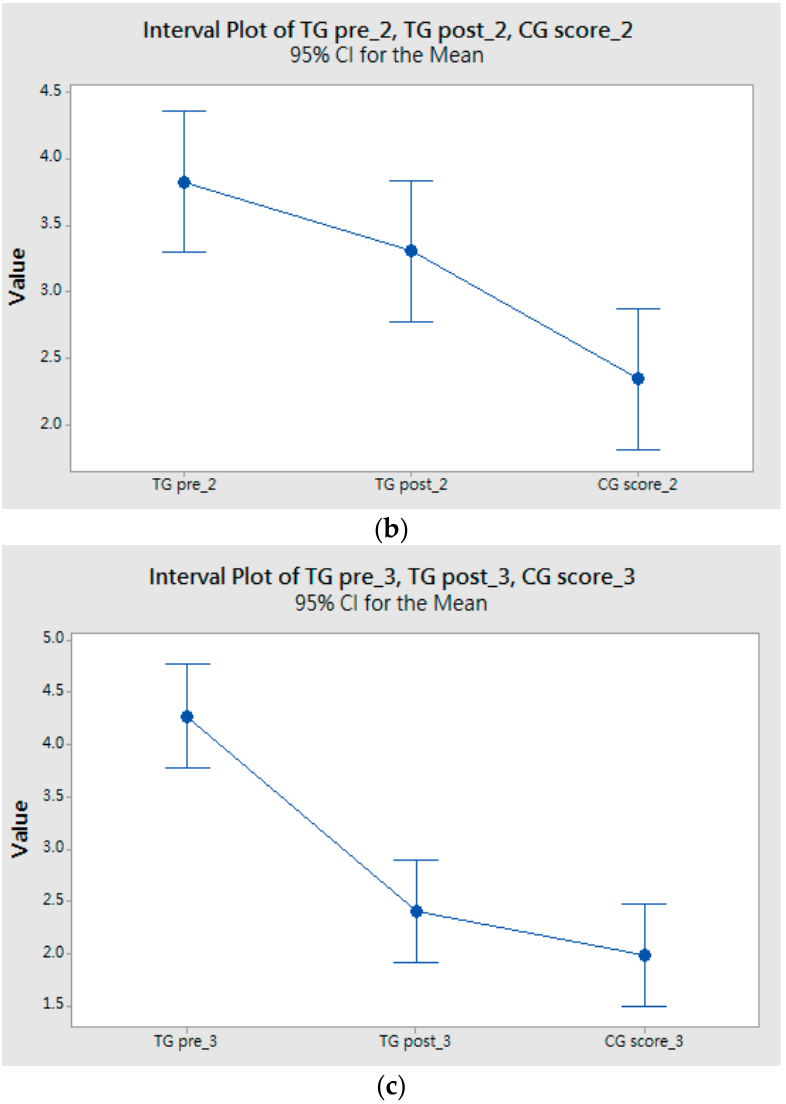
Figure 8. ( a ) One-way ANOVA interval plot from anxious driving behavior questionnaire (Q1~Q19); ( b ) one-way ANOVA interval plot from anxiety-related-avoidance questionnaire (Q20~Q32); and ( c ) one-way ANOVA interval describing specific driving environment questionnaire responses (Q33~Q39).